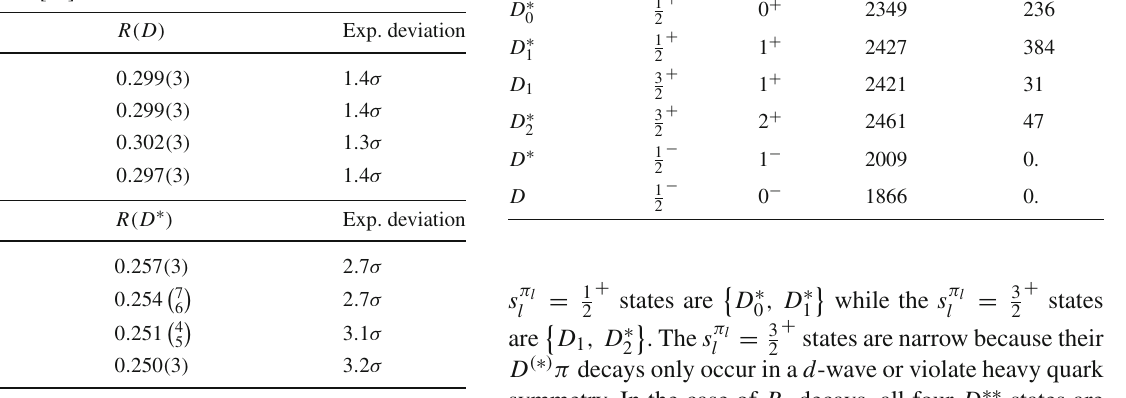
Table 3 Recent theory predictions for R ( D ( ∗ ) ) . The deviations are calculated from the HFLAV spring 2019 updates R ( D ) exp = 0 . 340 ( 27 )( 13 ) [49,58–61] and R ( D ∗ ) exp = 0 . 295 ( 11 )( 8 ) [49,58–67], respectively. For older predictions see Refs. [82–84]. Table adapted and extended from Ref. [85]